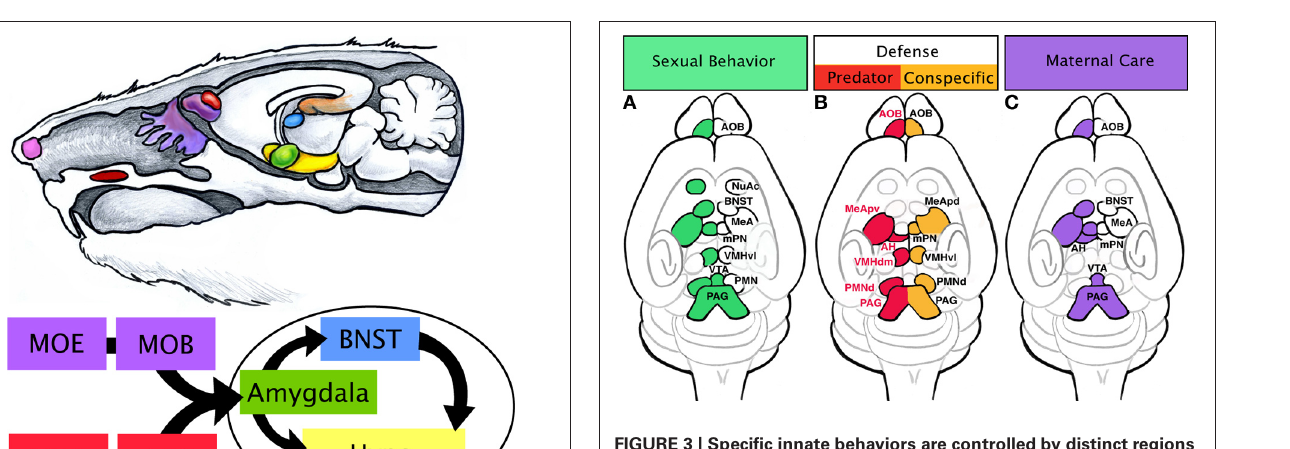
FIGURE 3 | Specific innate behaviors are controlled by distinct regions of the limbic system. (A) Sexual behaviors include activation of the vomeronasal organ (VNO), accessory olfactory bulb (AOB), and medial amygdala (MeA). Signal transduction from sensation to physical motivation is not always linear; once signal has reached the MeA, it is dispersed to a few areas: bed nucleus of stria terminalis (BNST), medial preoptic nucleus (mPN), and premammillary nucleus (PMN). The BNST will shunt signal from the MeA to the mPN. The mPN can activate appetitive behaviors (sniffing and pursuit) through innervation of the nucleus accumbens (NuAc) and ventral tegmental area (VTA). Additionally, the mPN passes information to the ventrolateral portion of the ventral medial hypothalamus (VMHvl), which in turn can initiate consummative behaviors through the periaqueductal gray (PAG) and spinal cord. Consummative behaviors such as mounting, intromission, and ejaculation can also be influenced by PMN inputs on the PAG and spinal cord. (B) Defensive behaviors trigger slightly different areas of the amygdala and hypothalamus depending if the stimulus is a predator or an animal of the same species (conspecific). Defense in response to a predator initiated in the AOB sends signals to the posterioventral MeA (MeApv), then to the dorsomedial portion of the ventral medial hypothalamus (VMHdm). The VMHdm will then cross-talks with the anterior hypothalamus (AH), an instance of bidirectional communication. The VMHdm, then signals to the ventrolateral portion of the dorsal PMN (PMNd), which then signals to the dorsolateral and dorsomedial PAG. Defense responses to a conspecific are initiated in the AOB which sends afferents directly to the anterior dorsal and posterior dorsal MeA (MeApd). The MeApd acts as a hub dispersing signal to three areas: mPN, VMHvl, and dorsomedial portion of the PMNd. The VMHvl will engage in cross-talk with the PMNd, which ultimately communicates with the dorsomedial and lateral PAG. (C) Maternal behavior circuit may begin in the AOB, which sends signal to the MeA. The MeA will send information to the mPN either directly or through the BNST. Pup avoidance is suppressed in the MeA and AH to initiate pup approach. Appetitive behaviors such as pup retrieval occur through activation of the VTA by the mPN. Consummative behaviors such as nursing are executed via activation of the PAG and spinal cord by the